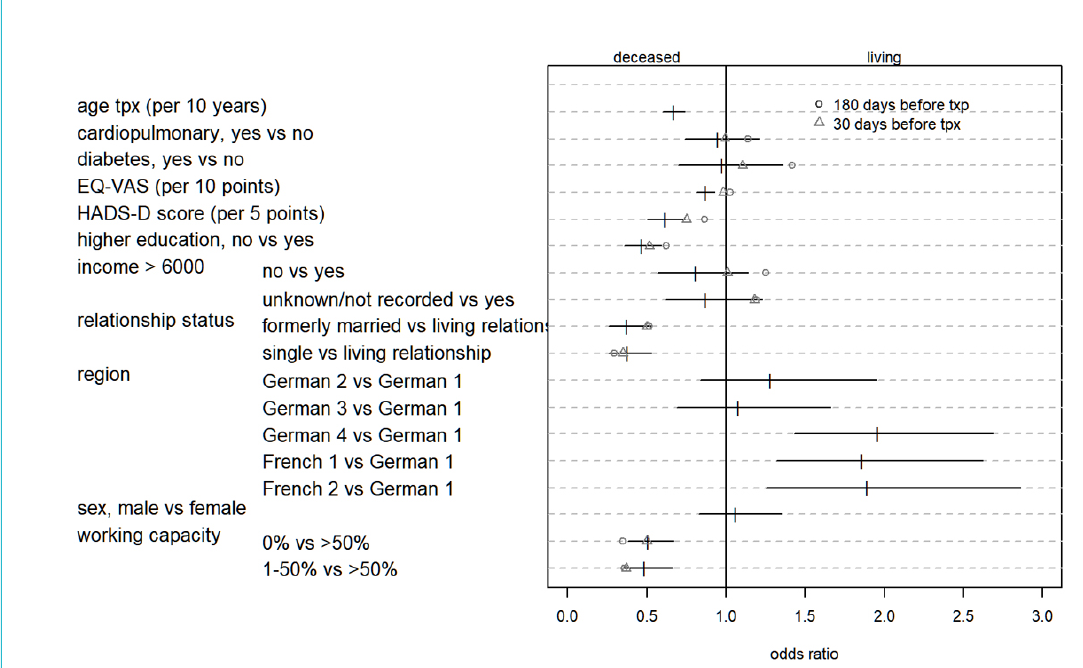
Figure S3: Odds ratio and 95% confidence intervals for covariates for the logistic regression model for outcome LDRT. In addition, regression coefficients for two subgroups are shown: Δ with candidates filled in PSQ at least 30 days (n: DDRT 867, LDRT 315); O with candidates filled in PSQ at least 180 days (n: DDRT 767, LDRT 166) before transplant event. Only estimates for covariates that might change over time are shown for the subgroup analysis. DDRT = deceased donor renal transplant; HADS = hospital anxiety and depression scale; LDRT = living donor renal transplant; PSQ = Swiss Transplant Cohort Study psychosocial